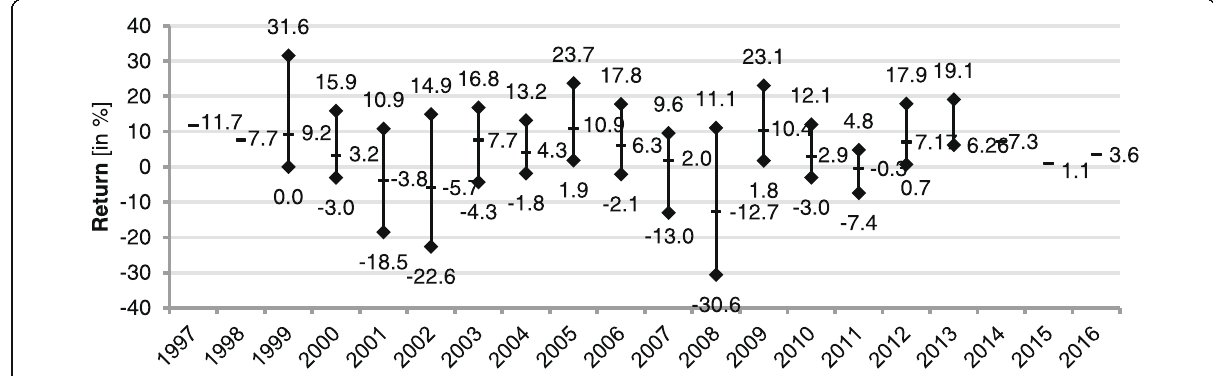
Fig. 3 Mean, minimal and maximal return of Swiss pension